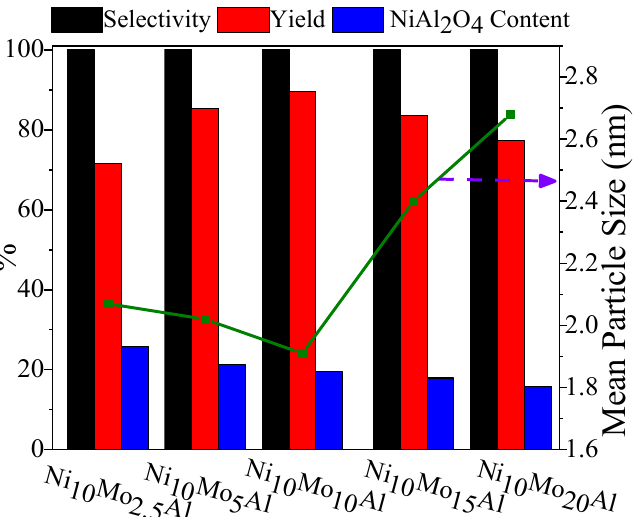
Figure 11. Catalytic evaluation of Ni 10 Mo x Al catalyst series at the reaction conditions of 100 °C, 1 MPa H 2 , n(H 2 )/n(MA) = 4 and WHSV = 2 h − 1 . 1 MPa H 2 , n(H 2 )/n(MA) = 4 and WHSV = 2 h − 1